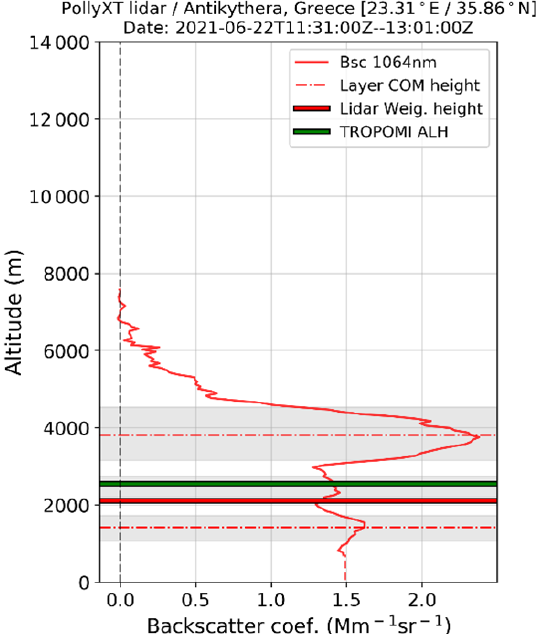
Figure 5. Lidar backscatter profile at 1064nm (ALH bsc , red line) at Antikythera, Greece, on 22 June 2021. The lidar-weighted aerosol height calculated by Eq. (1) is shown as a thick red line. The calcu- lated centre of mass (COM) of the two identified layers is shown as a dashed–dotted red line, and their thickness is shown by the grey areas. The TROPOMI mean ALH is given as a thick green